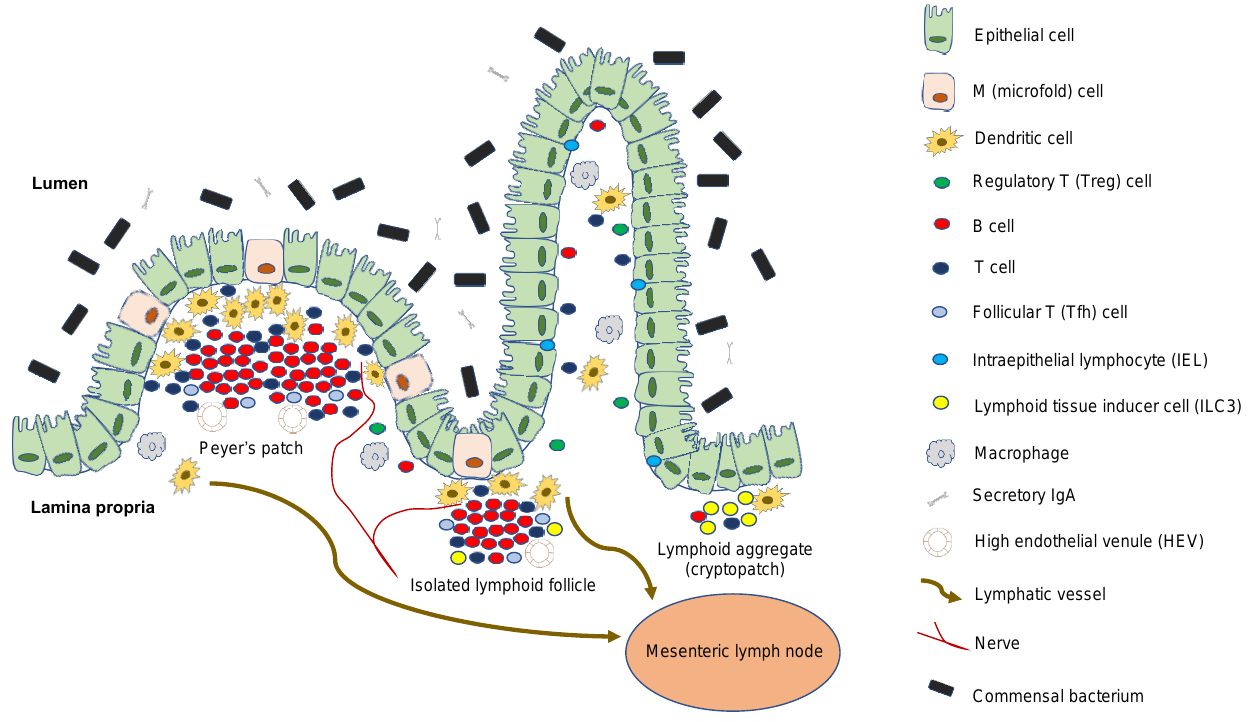
Figure 2. Composition of Peyer ’ s patches and isolated lymphoid follicles: The intestinal lamina propria is separated from the gut flora by a single epithelial cell layer; it is protected by a thick layer of mucus, bactericidal defensins, neutrophils, and a large amount of secretory IgA specific to antigens. Intraepithelial lymphocytes monitor epithelial damage, and may recognize microbial antigens within the epithelium. The lamina propria is densely packed with T cells, plasma cells that produce IgA, and macrophages; it also contains a large number of dendritic cells, which migrate through the lymph to mesenteric lymph nodes, and present antigens to T cells. Microfold cells are found in the follicle-associated epithelium, and transport luminal antigens to Peyer ’ s patches or isolated lymphoid follicles for collection by dendritic cells, which can also collect antigens from apoptotic epithelial cells.